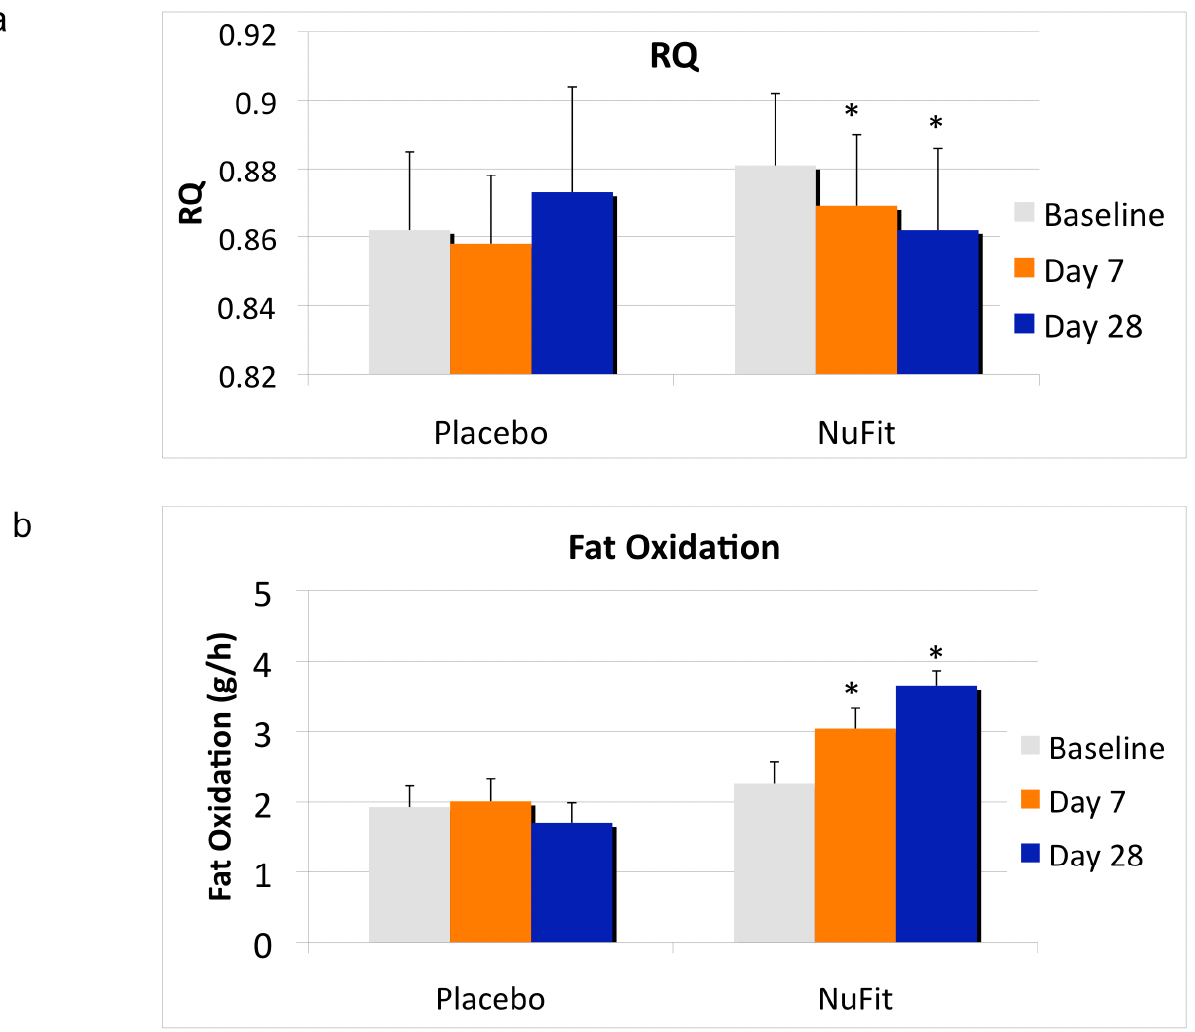
Figure 1. The effects of the NuFit active blend and placebo on ( a ) respiratory quotient (RQ) and ( b ) fat oxidation. Twenty overweight or obese subjects received the NuFit active blend or placebo for 4 weeks. Fat oxidation and the RQ were assessed at baseline, days 7 and 28. RQ was calculated as CO production/O consumption and substrate oxidation was 2 2 calculated from RQ after correction for urinary nitrogen losses. Values are expressed as mean ± SE. * denotes significant difference to baseline, p <